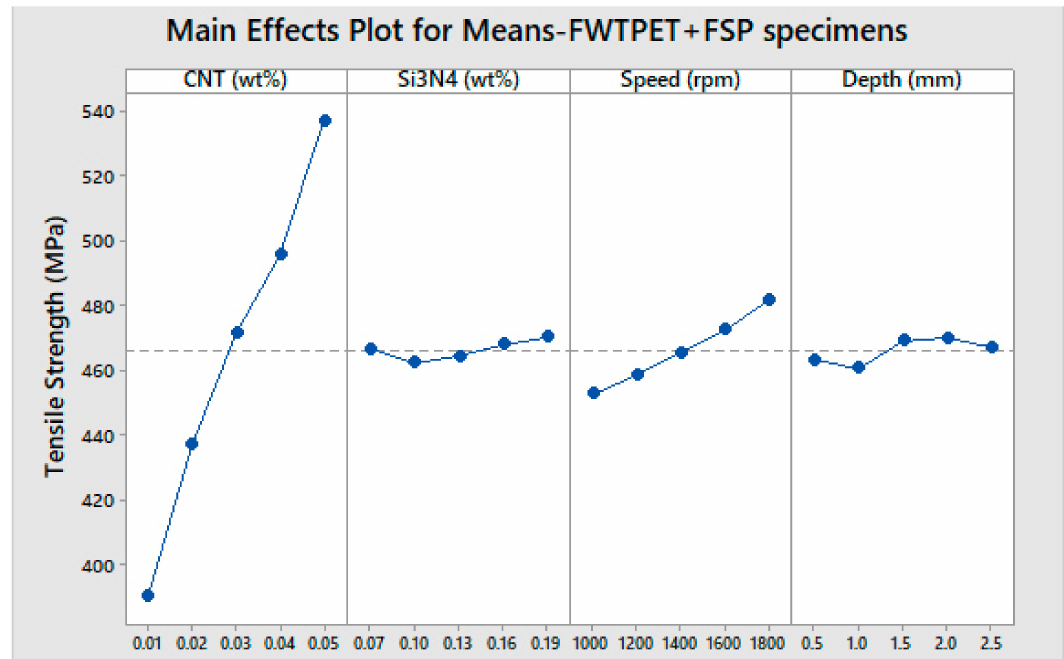
Figure 6. The main e ff ect plot (means) for FWTPET + FSP specimens.